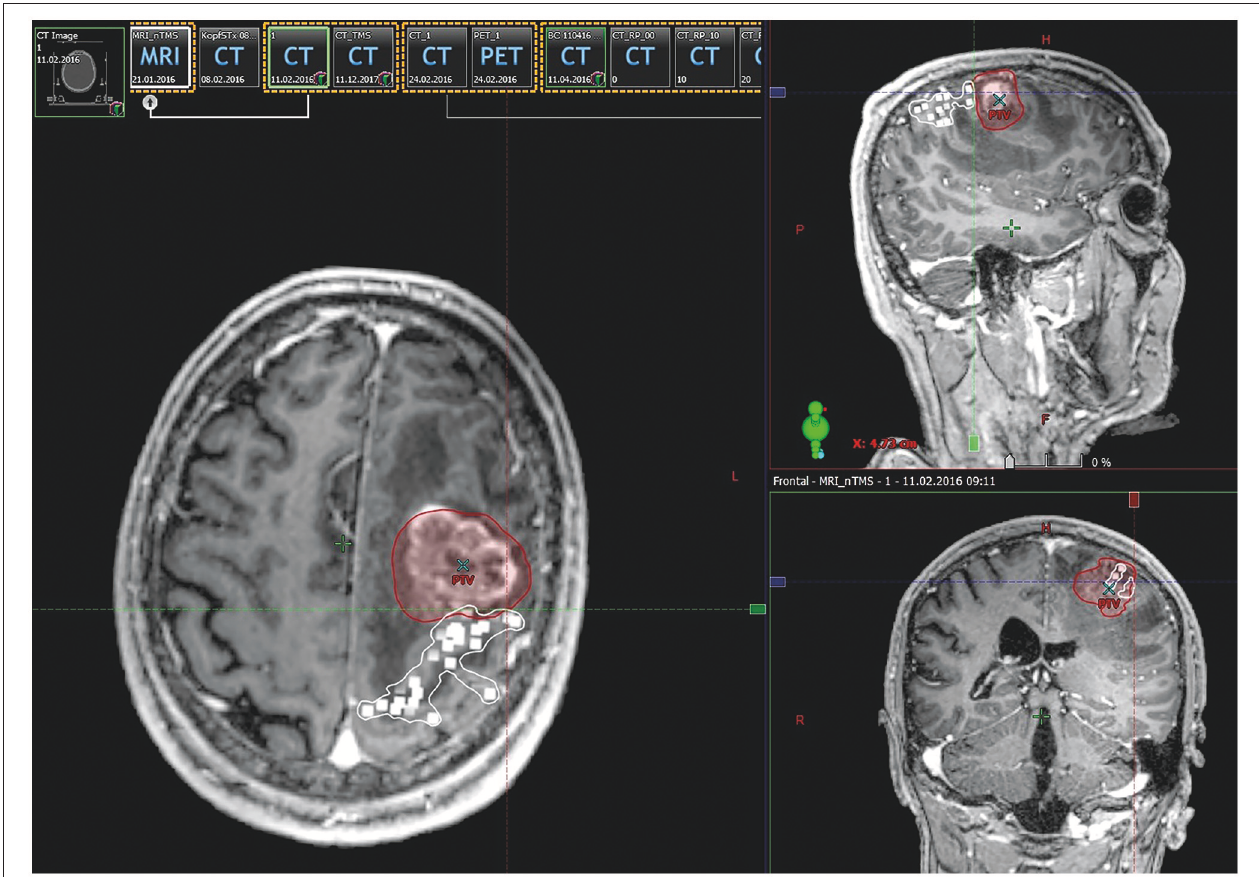
FIGURE 1 | Integration of motor maps in target volume delineation. This figure shows contrast-enhanced, T1-weighted magnetic resonance imaging (MRI) fused with navigated transcranial magnetic stimulation (nTMS) motor-positive points (white squares) in an exemplary patient case. For radiotherapy (RT) planning, nTMS motor maps were contoured as coherent organs at risk (OARs) in terms of target volume delineation. The planning target volume (PTV) is depicted as a red area.